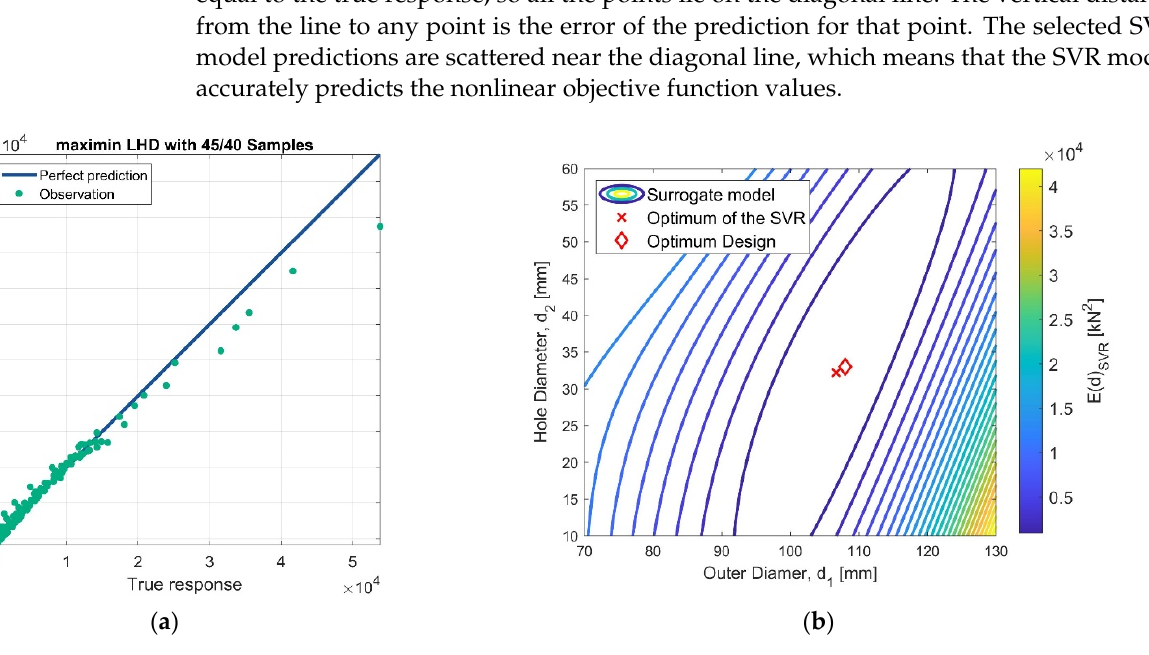
Figure 7. ( a ) Comparison of the FEA calculated objective function values with the SVR predicted responses in the test dataset points. ( b ) The isoline plot of the surrogate model in the feasible region.